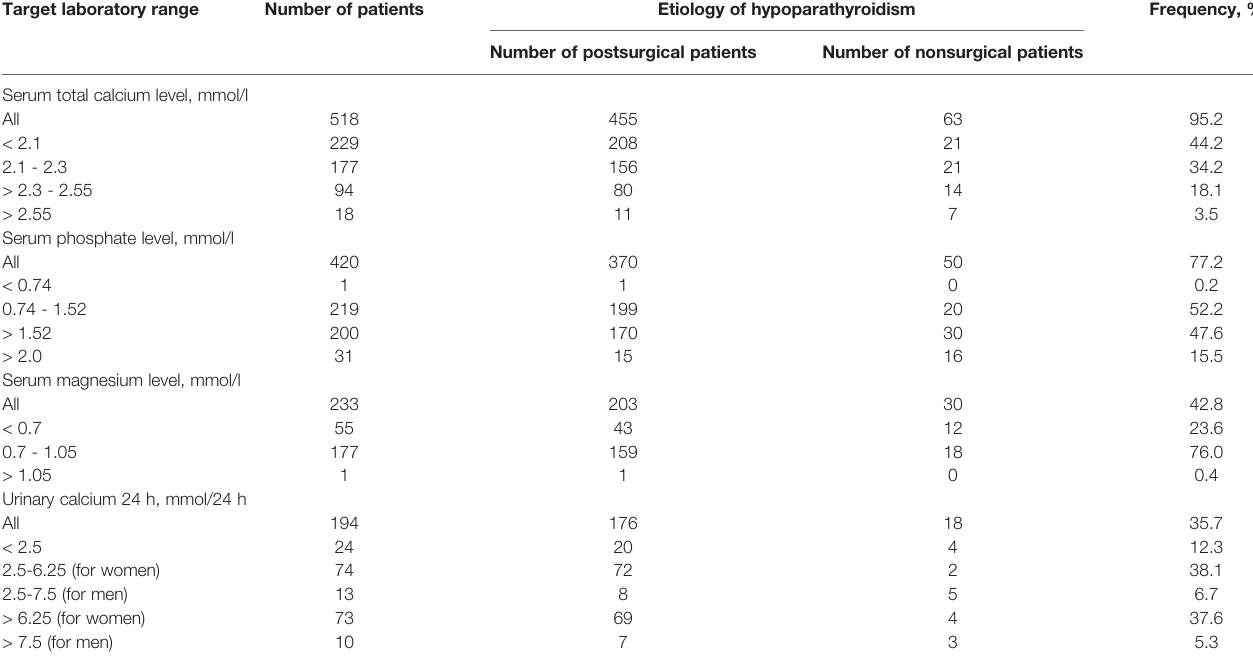
TABLE 2 | Biochemical exams of mineral metabolism for patients with hypoparathyroidism. Target laboratory